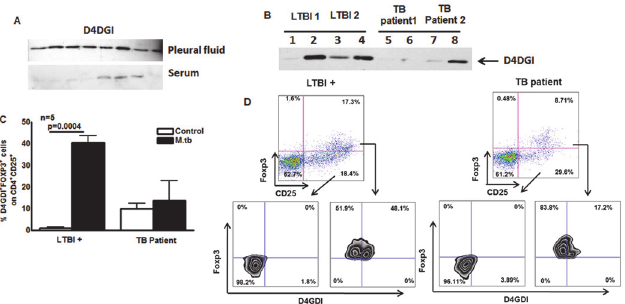
Figure 10. D4GDI expression by TB patients. (A) D4GDI is highly expressed in pleural fluid of TB patients. Pleural fluid and serum from 10 patients were collected, and equal amounts of protein were subjected to Western blotting with a monoclonal antibody to D4GDI. Data from 8 patients are shown. (B) PBMC from TB patients express reduced amounts of D4GDI. PBMC from 5 donors with LTBI and 5 TB patients were cultured with γ -irradiated H37Rv (10 μ g/ml). After 5 days, culture supernatants were subjected to Western blotting with monoclonal antibody to D4GDI. Data from 2 patients and 2 individuals with LTBI+ are shown. (C) Intracellular staining for FOXP3 + D4GDI + cells. CD4 + cells from PBMC of 5 donors with LTBI+ and 5TB patients were cultured with autologous monocytes in medium alone, or with γ -irradiated H37Rv (10 μ g/ml). After 4